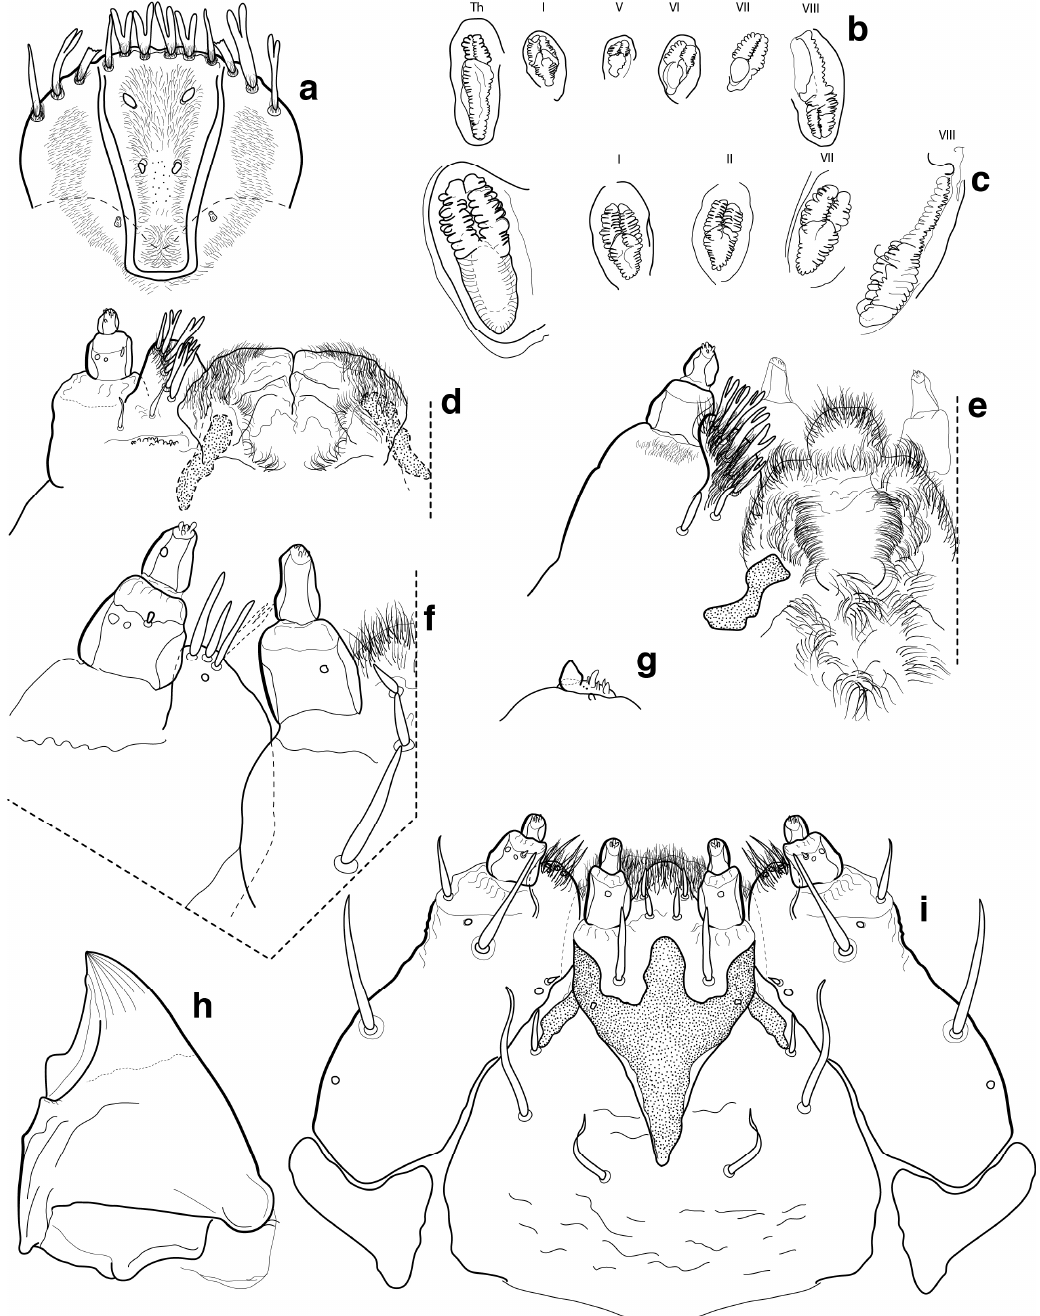
Figure 85. Sphenophorus spp. mouthparts and spiracles: ( a ) Sphenophorus pontederiae, epipharynx; ( b ) Sphenophorus pontederiae, spiracles; ( c ) Sphenophorus maidis spiracles; ( d ) Sphenophorus maidis , maxillae and hypopharynx, dorsal view; ( e ) Sphenophorus maidis, maxillae and hypopharynx, dorsal view; ( f ) Sphenophorus maidis, detail, mala and labium, ventral view; ( g ) Sphenophorus maidis, antenna; ( h ) Sphenophorus maidis, mandible; and ( i ) Sphenophorus maidis, labio-maxillary complex, ventral view.